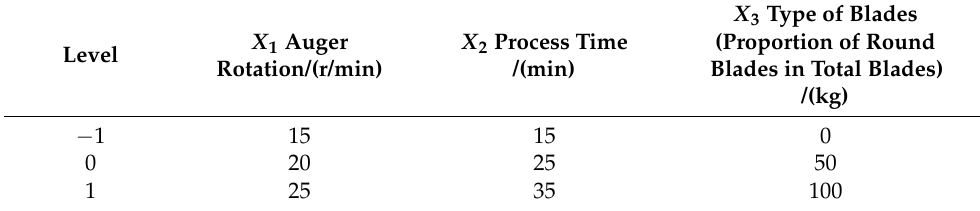
Table 1. Factor level coding